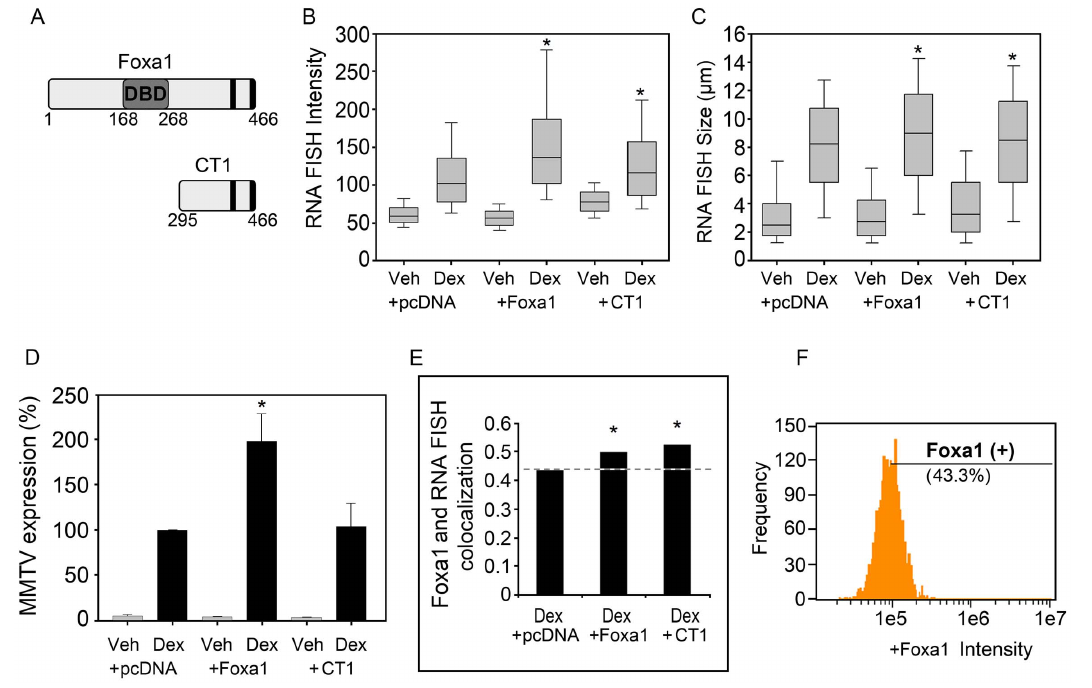
Figure 4. Foxa1 expression in the 3134 cell line enhances MMTV-Ras transcription. (A) Schematic of full-length Foxa1 and the C-terminal CT1 truncation mutant. The central DBD region interacts with DNA. Two C-terminal regions (black vertical bars) are important for core histone interactions. (B, C) Box-and-whisker plots of the RNA FISH signal intensity (mean pixel intensity units) and size ( m m) distributions within each cell group. Sample sizes for each condition: Veh + pcDNA (n=899), Dex + pcDNA (n=4584), Veh + Foxa1 (n=1067), Dex + Foxa1 (n=2195), Veh + CT1 (n=225), Dex + CT1 (n=1959). (D) Comparative analysis of Ras RNA expression by qRT-PCR. Ras RNA expression is normalized to mouse b -actin. Data are expressed relative to that of Dex + pcDNA which is set to 100% (n $ 3). (E) Bright Detail Similarity of Foxa1 colocalization with the RNA FISH foci. (F) Quantification of the percentage of total Foxa1-transfected cells showing positive Foxa1 positive ( + ) immunofluorescence. *, indicates a significant difference from the Dex + pcDNA group in each graph as determined by the Mann-Whitney U Test (p ,